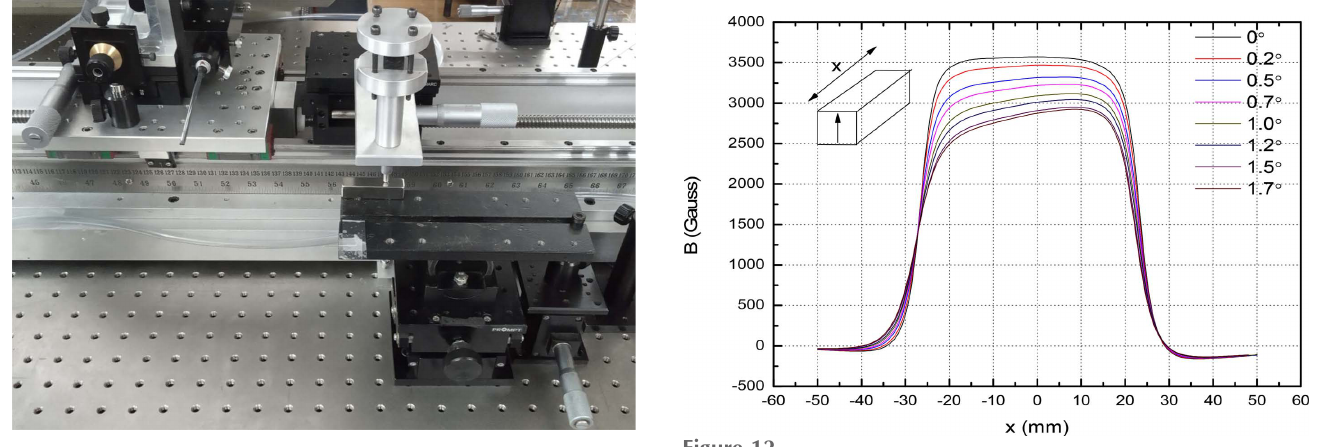
Figure 10 Magnet measurement set-up and interferometer readout.